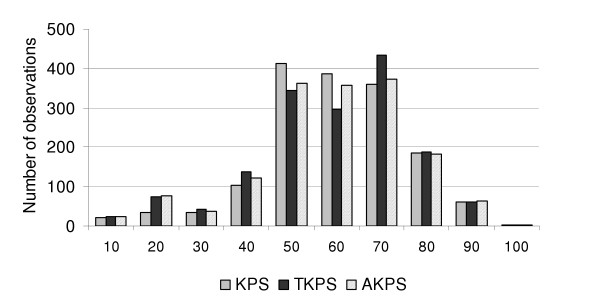
Profile of KPS, TKPS and AKPS scores in the 1600 observations.